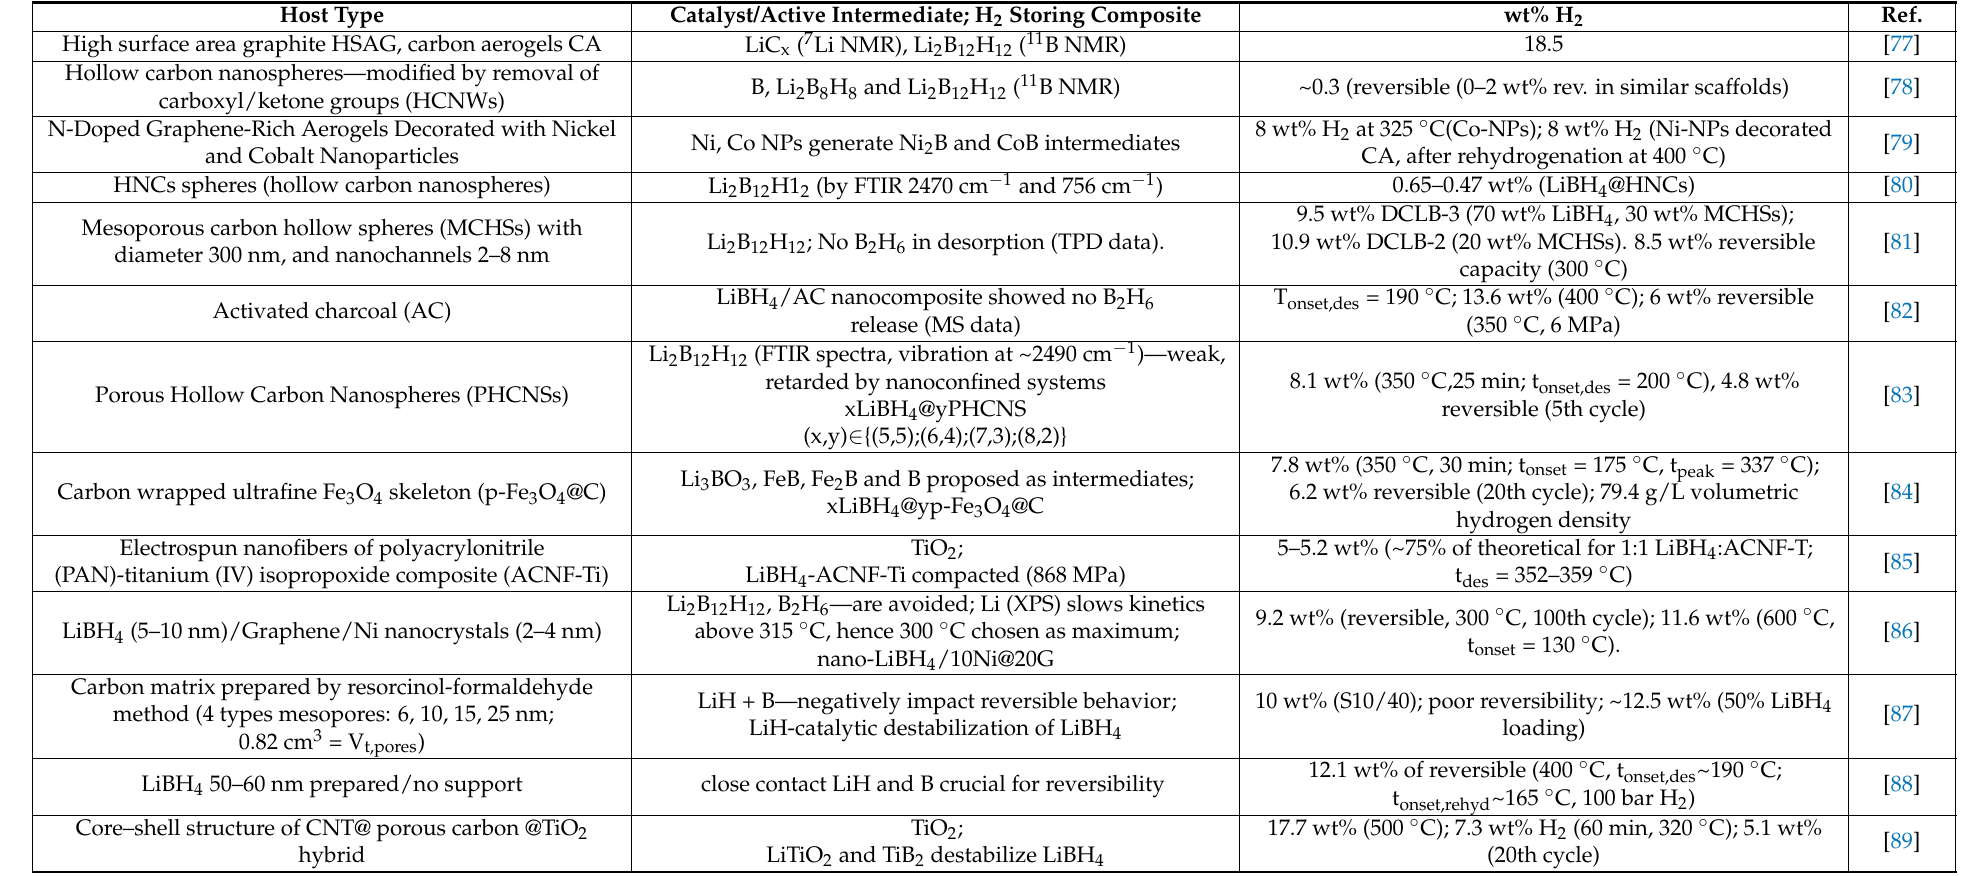
Table 1. LiBH 4 -based nanostructured systems and specific details regarding hydrogenation storage